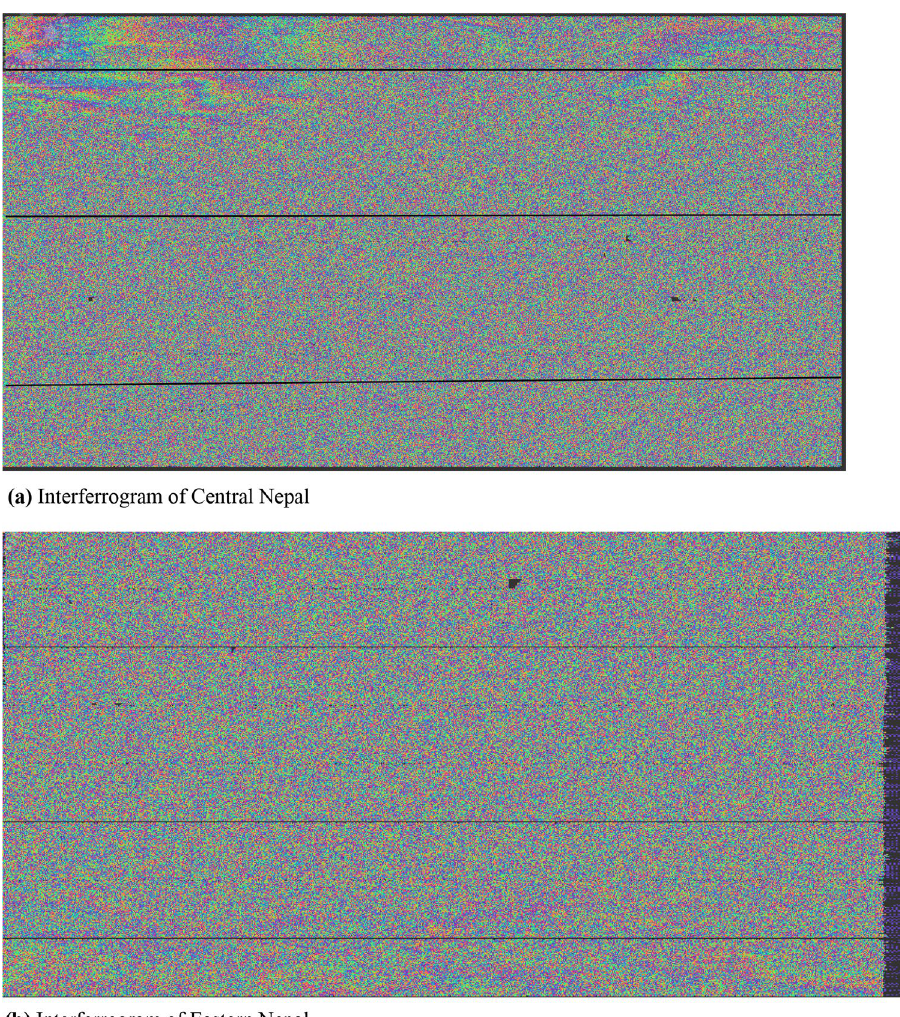
Fig. 6 a Interferogram of Central Nepal. b Interferogram of Eastern Nepal